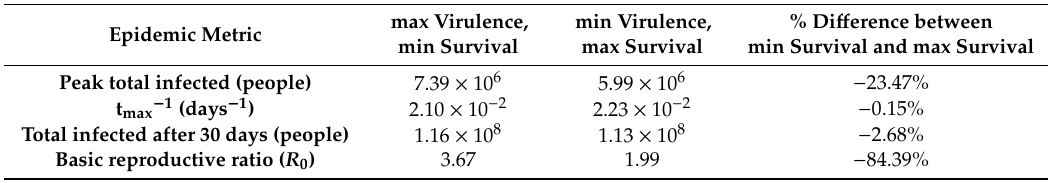
Figure 6. The percent change in SEAIR-W outbreak metrics as survival increases from − 5% to + 5% for di ff erent virulence–survival relationships (positive correlation and negative correlation). For each metric analyzed, we present the percent di ff erence between the minimum and maximum survival values given the two hypotheses tested: (i) positive correlation between survival and virulence (comparing low virulence / low survival to high virulence / high survival) and (ii) negative correlation (high virulence / low survival to high survival / low virulence). The bars here correspond to the values (percent) in the third columns of Tables 5 and 6, which denote the di ff erences between the minimum and maximum values. Table 6. Negative correlation scenario: comparing epidemic metrics under low survival / low virulence versus high survival / high virulence scenarios (as in the negative correlation scenario). For each metric analyzed, these are the global heatmap values for the top left (at “coordinates” (Vir, Sur) → ( + 5%, − 5%)) and bottom right corners (at “coordinates” (Vir, Sur) → ( − 5%, +